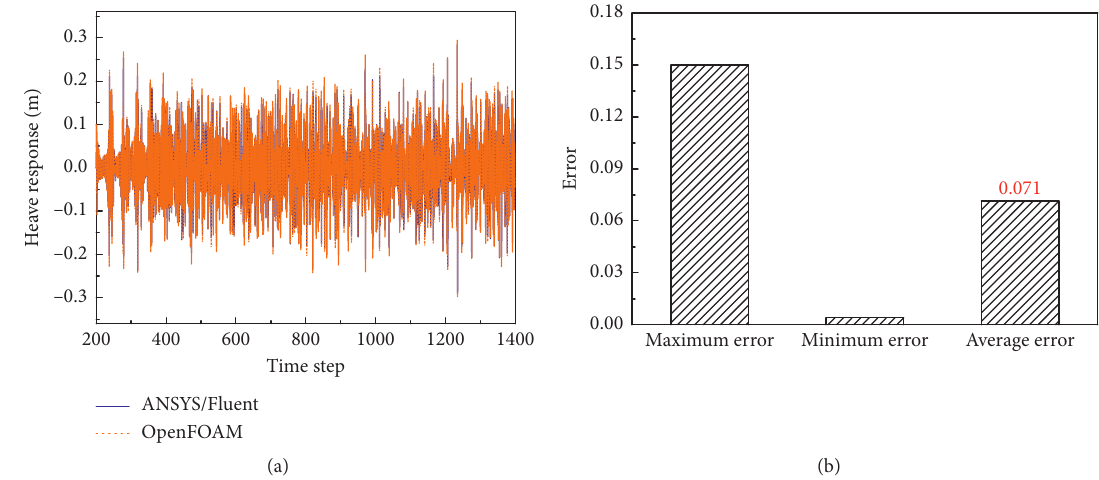
Figure 10: The heave response comparisons of the offshore wind turbine platform by ANSYS/Fluent and OpenFOAM: (a) the time series of heave displacement and (b) the average error and time cost ratio statistics compared to OpenFOAM.